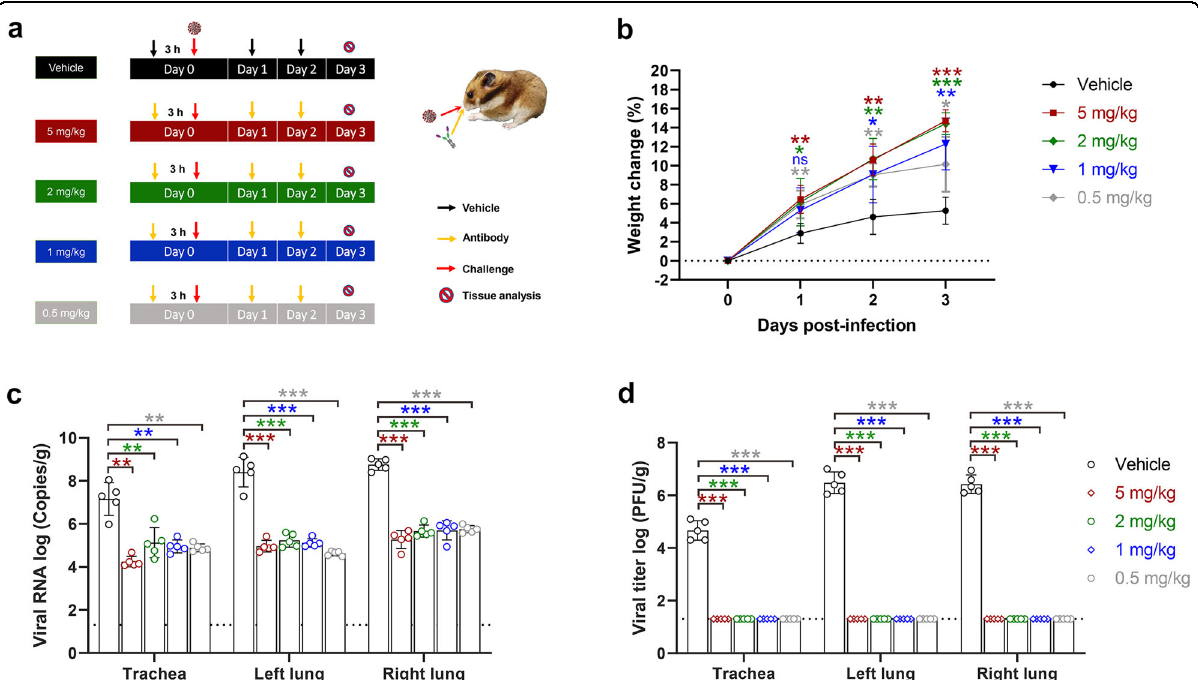
Fig. 5 I.n. delivered 2-3-Fc offers prevention against Omicron in hamsters. a Animal experiment scheme. Hamsters were divided into 5 groups ( n = 5 per group), including a control group administered vehicle (PBS) and four treatment groups administered doses of 5 mg/kg, 2 mg/kg, 1 mg/kg, and 0.5 mg/kg. b The body weight change of the animals in the control group and treatment groups was recorded daily and compared. c , d Viral RNA copies ( c ) and viral titers of infectious particles ( d ) in the trachea and lungs were measured at 3 dpi. Bars indicate the means ±